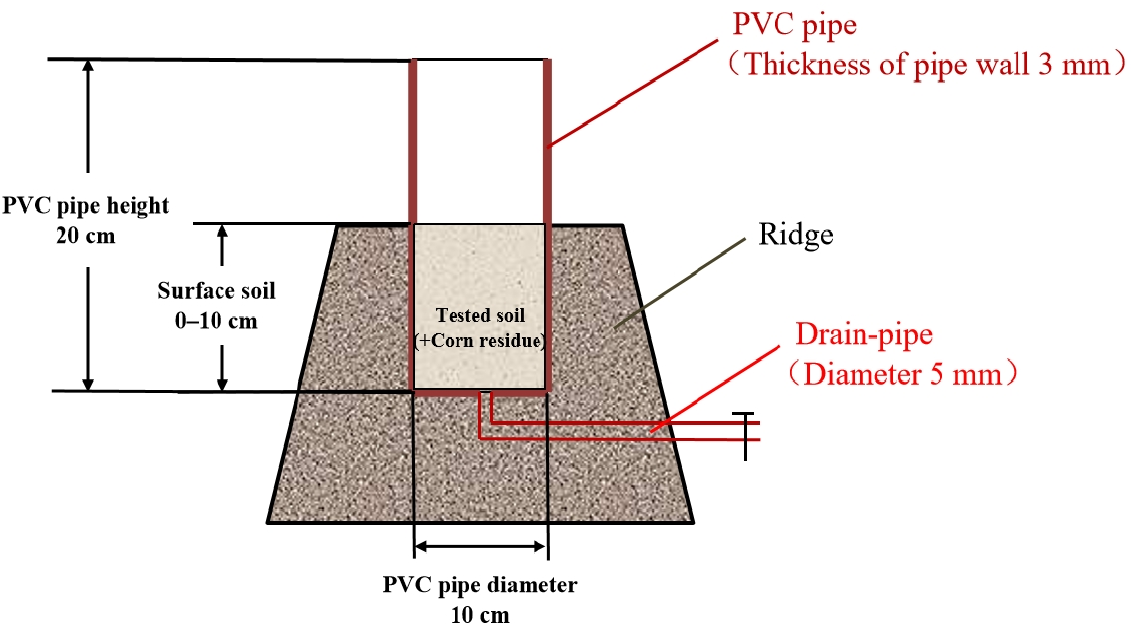
Figure 1. Schematic map of the tested device.